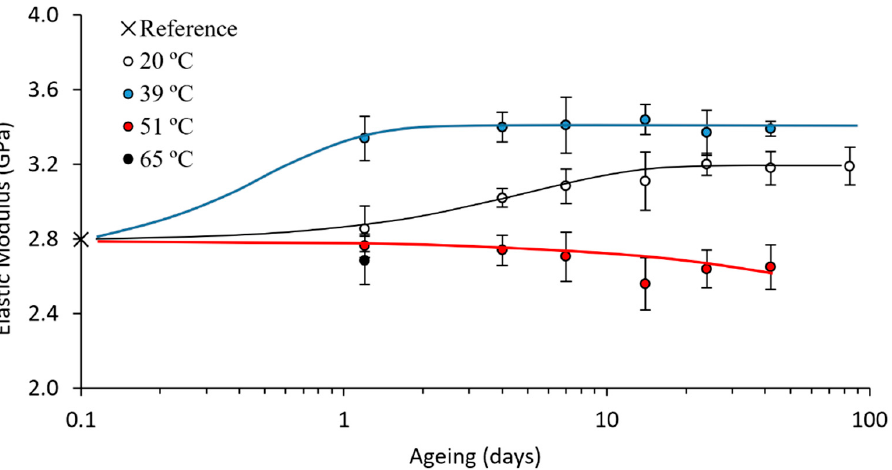
Figure 7. Elastic modulus evolution with ageing time at different ageing temperatures. Logistic fittings for 20 and 39 ◦ C, linear fitting for 51 ◦ C. These fittings correspond to Equations (3), (5), and (7), respectively.